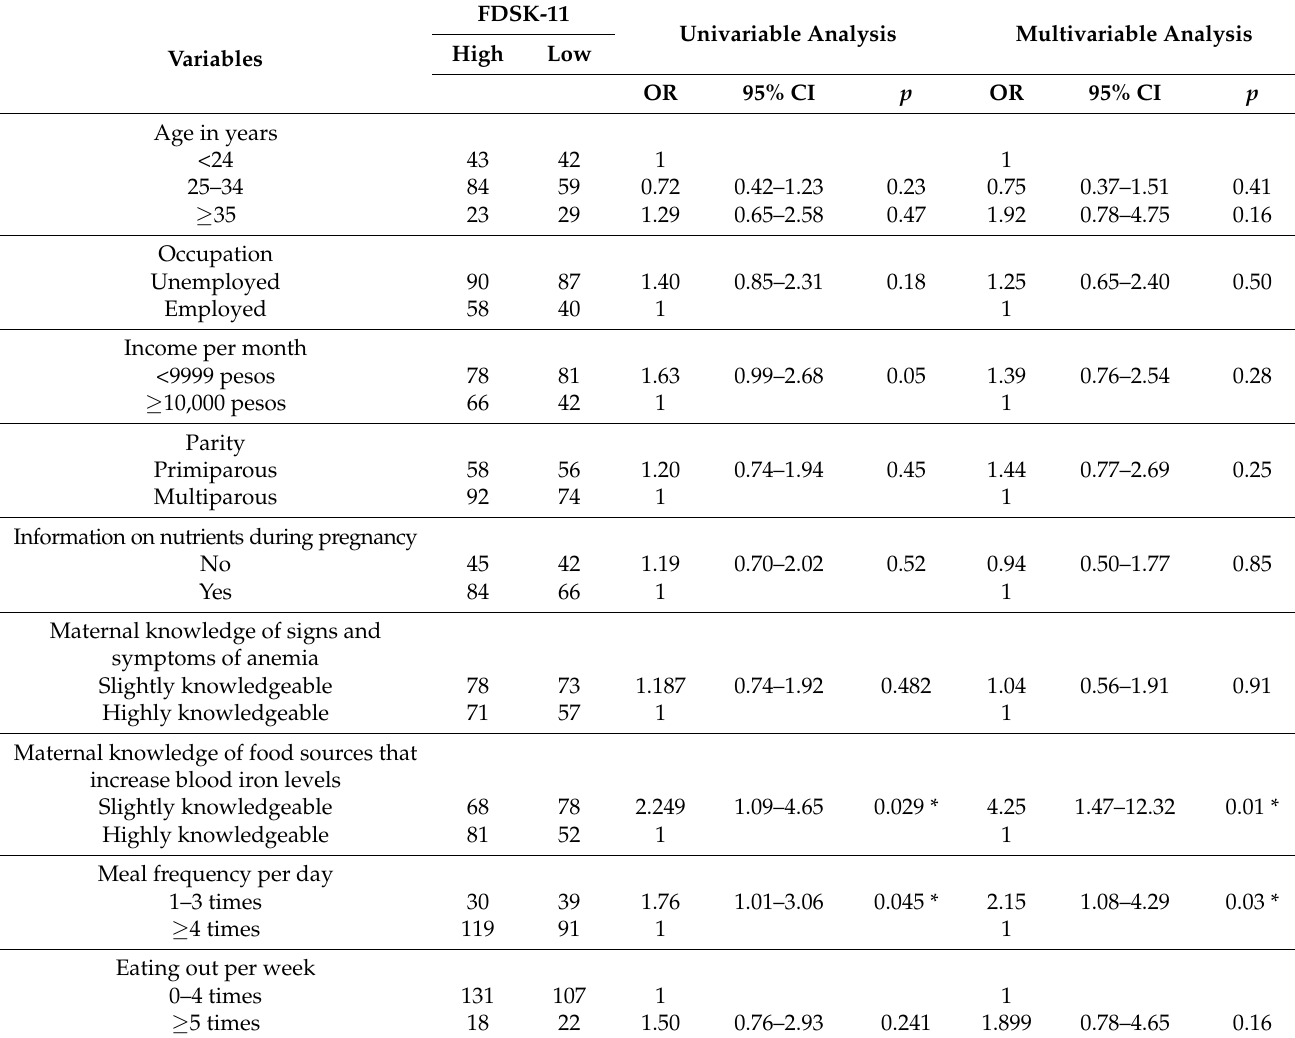
Table 3. Multivariable regression analyses of dietary diversity among the participants ( n =